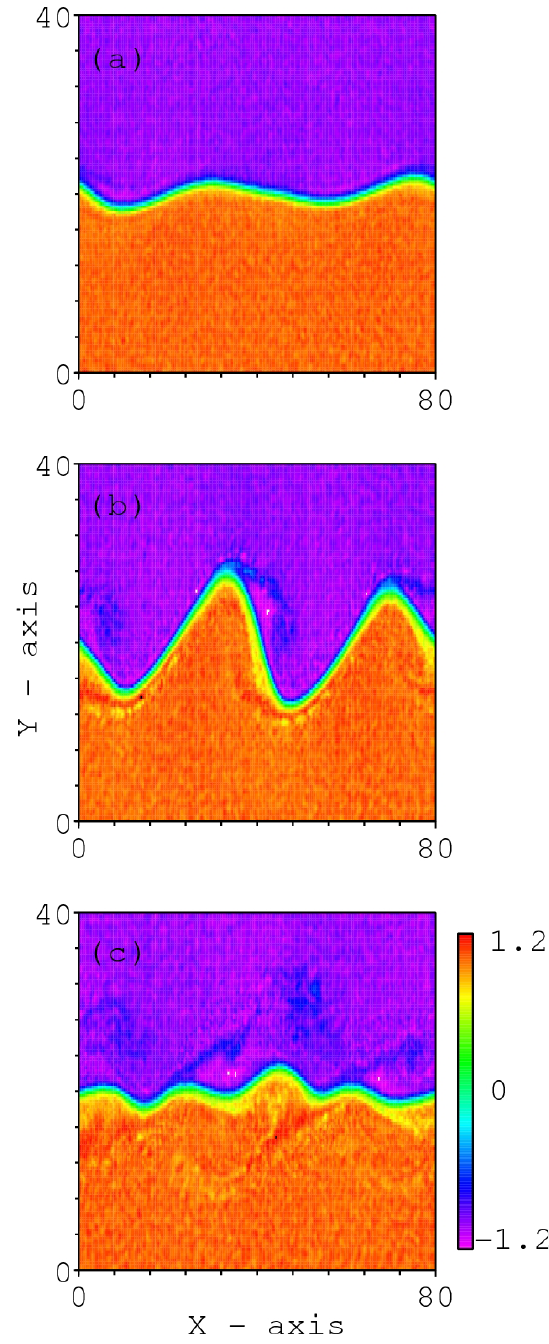
Fig. 3. Color-coded z-component of the magnetic field at (a) t = 120, (b) t = 200, and (c) t = 260 in the